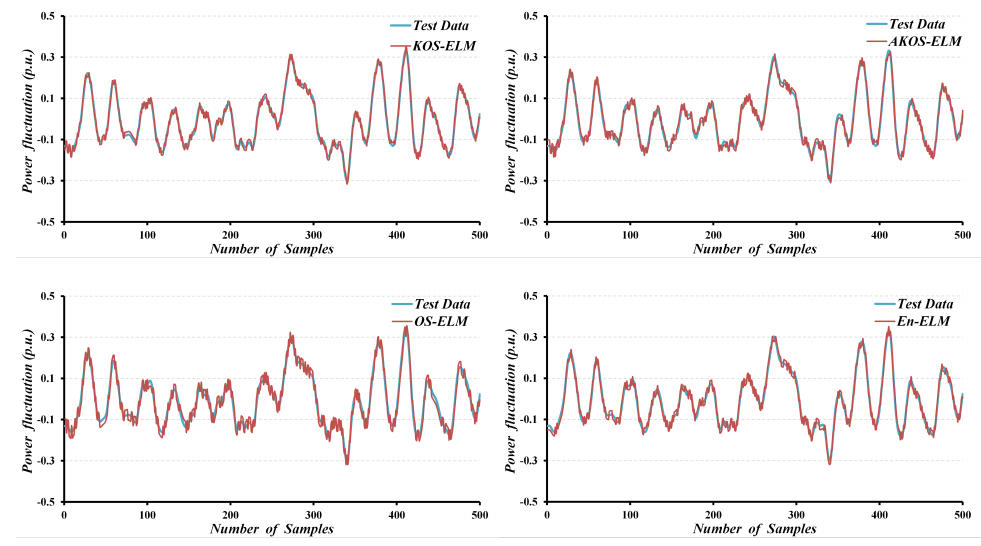
Figure 3. Prediction performance comparison of KOS-ELM, AKOS-ELM, OS-ELM, En-ELM, LSTM using Level-3 data set (part a).